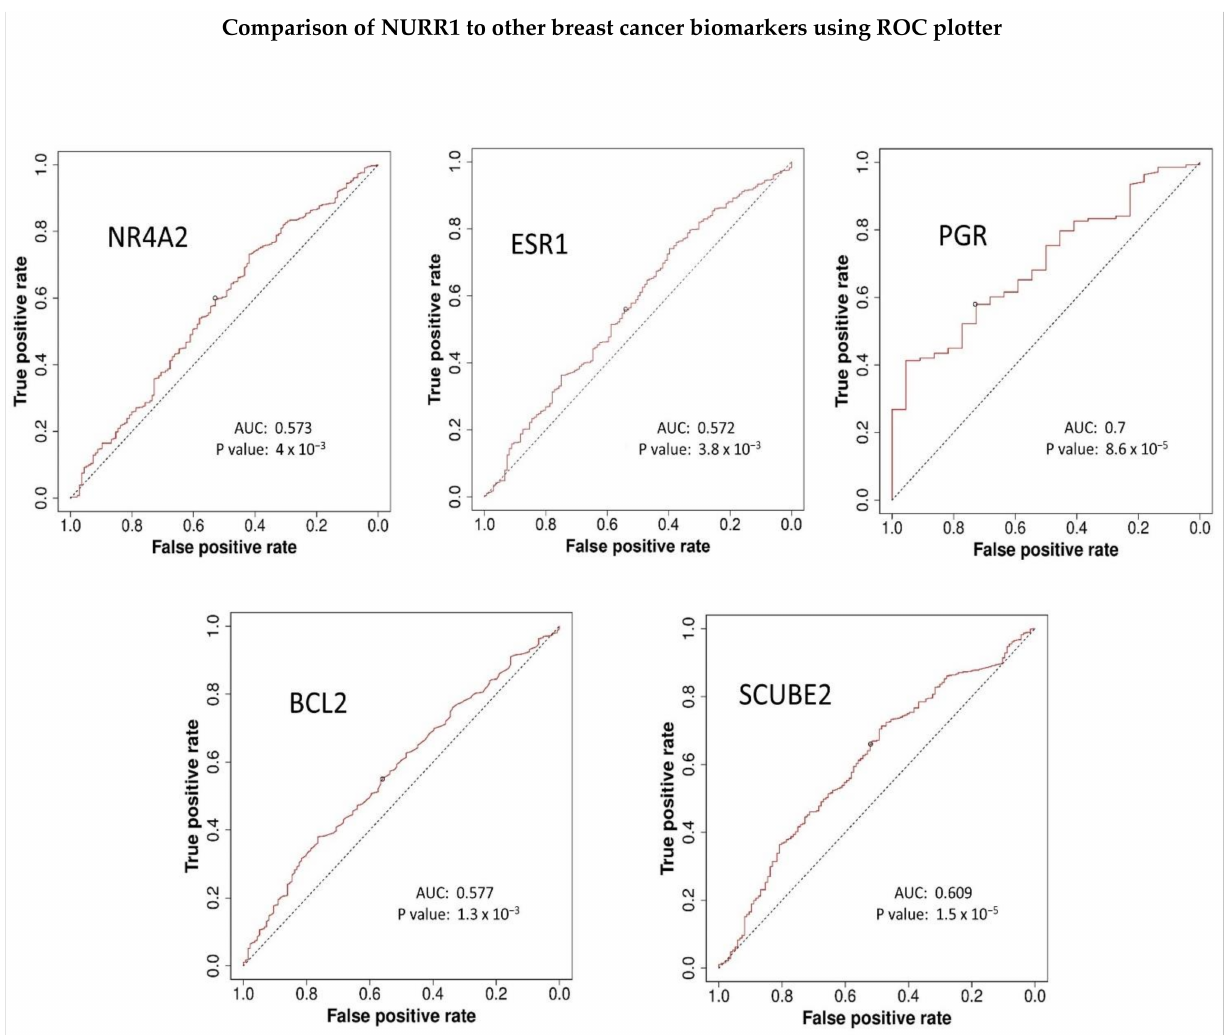
Figure 6. ROC plotter predictive biomarker analysis suggests NURR1 can be potential breast cancer biomarker. The AUC of NURR1 expression in total population with 5-year relapse free survival with endocrine therapy in comparison to other breast cancer biomarkers was found to be similar especially with ESR1, BCL2, and SCUBE2. Table 2. The correlation of NURR1 expression with respect to expression of genes in Oncotype DX panel in Black and White breast cancer